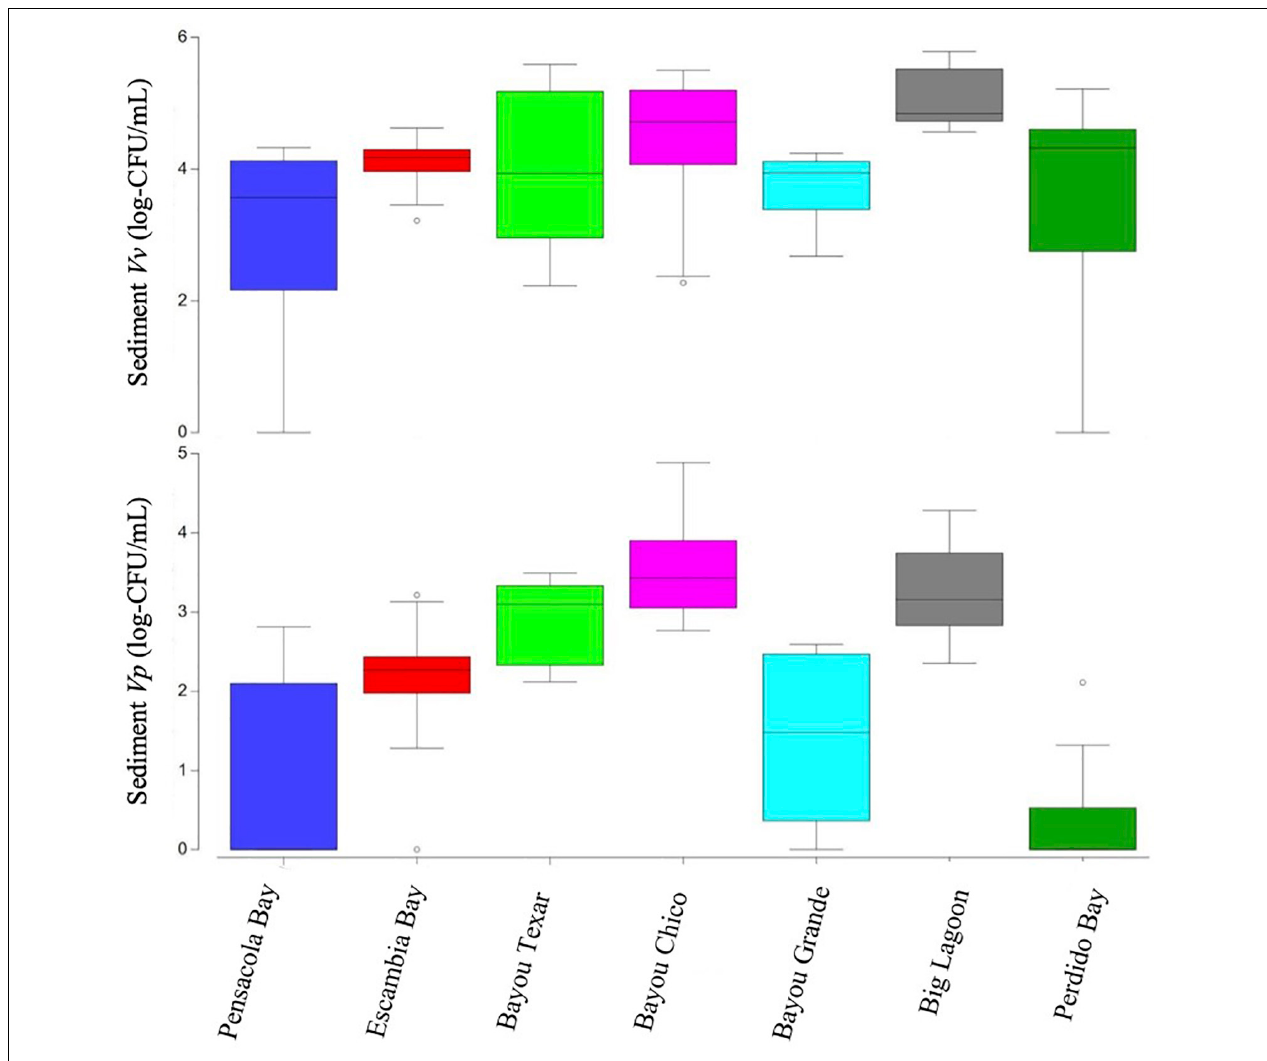
FIGURE 4 | Boxplots of Vibrio abundances in sediments. Open circles denote extreme values; box-tops and -bottoms show the 25th and 75th percentiles; lines within boxes mark mean values; and whiskers indicate minimums and